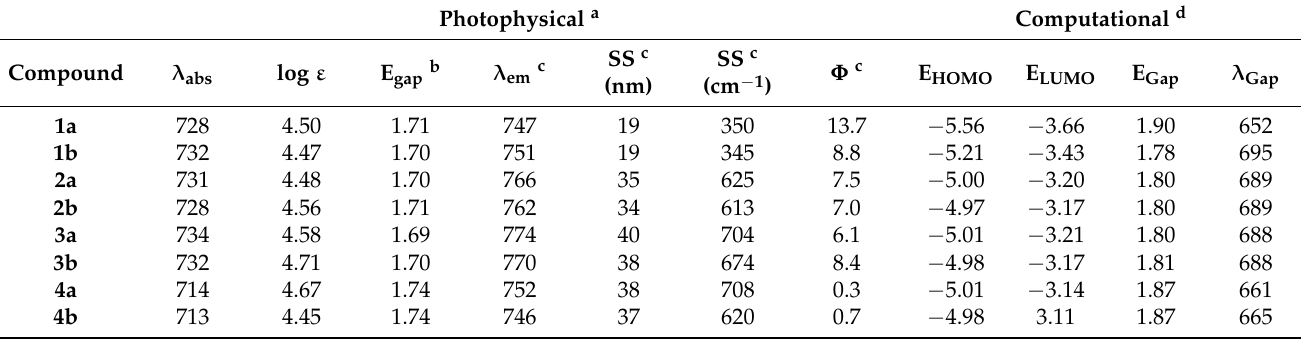
Table 1. Photophyiscal and computational data for bis(phenolate) aza-DIPYs 1a-b , 2a-b , 3a-b , and